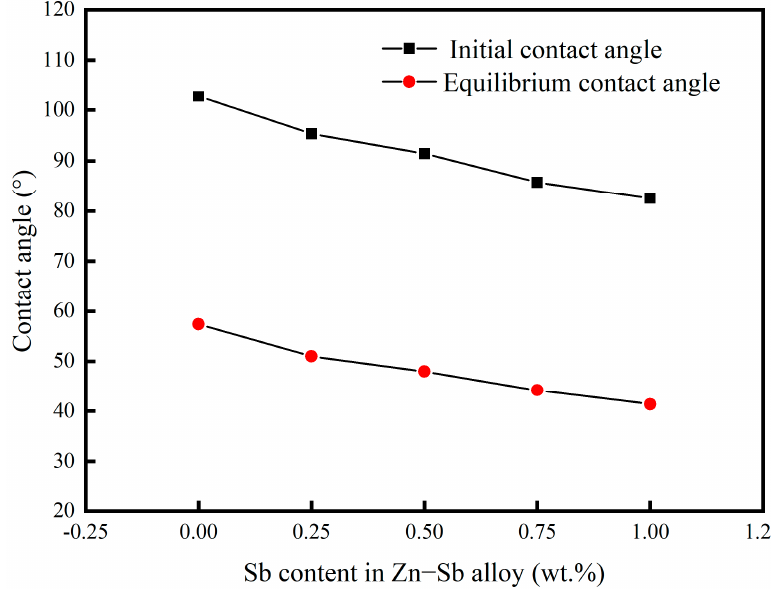
Figure 1. Contact angle of Zn–Sb alloy and X80 steel under different Sb content.